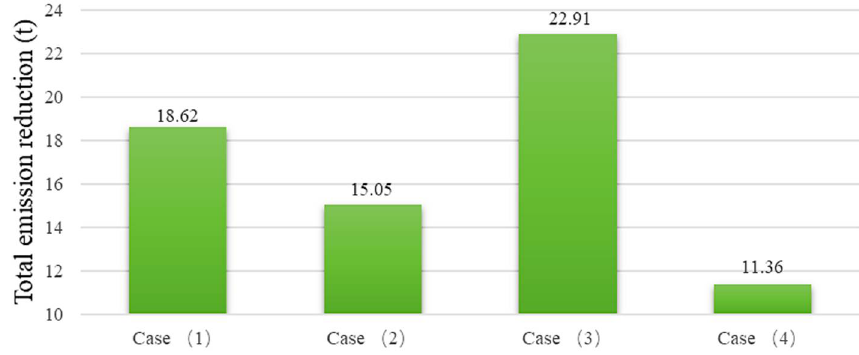
Figure 13. The emission reduction of HFCVs for cases. Table 13. The parameters of emission reduction of HFCVs for cases.